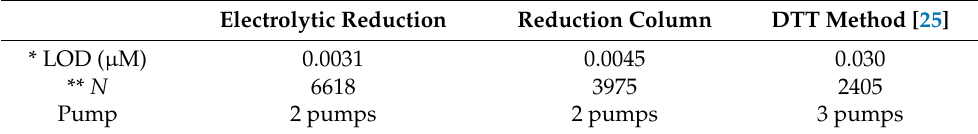
Table 3. The comparison between the proposed methods and the previous DTT